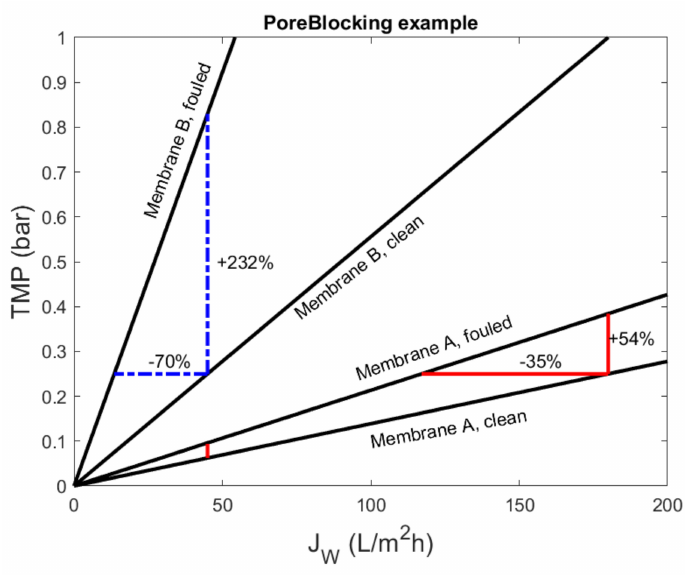
Figure 8. Relation between filtration flux and transmembrane pressure for clean and fouled mem- branes (final fouling state: v = 0.0262, R MA = 0.5 × 10 12 m − 1 , R MB = 2.0 × 10 12 m − 1 , v xA = 0.075 m, and v xB = 0.0375 m). In this figure, a constant-pressure experiment corresponds to moving over a hor- izontal line from the clean membrane to the fouled membrane. Similarly, a constant-flux experiment corresponds to a horizontal line. For every value of the filtration flux, the required transmembrane pressure (energy), for the fouled membrane A was 54% higher than for the clean membrane A (232% for membrane